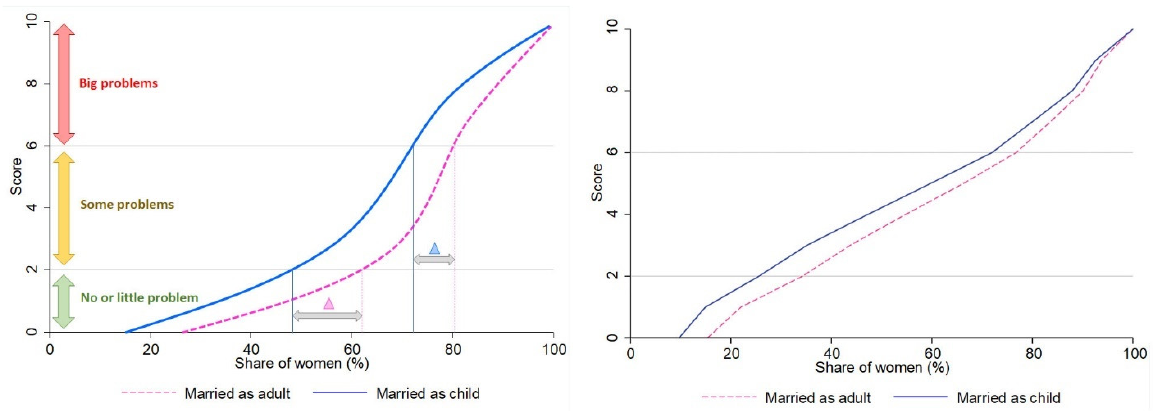
Figure 3. Distribution of healthcare access problem severity (based on composite score) by marriage age. The figure on the left illustrates the analytical framework, and the figure on the right presents the actual distribution in the sample.